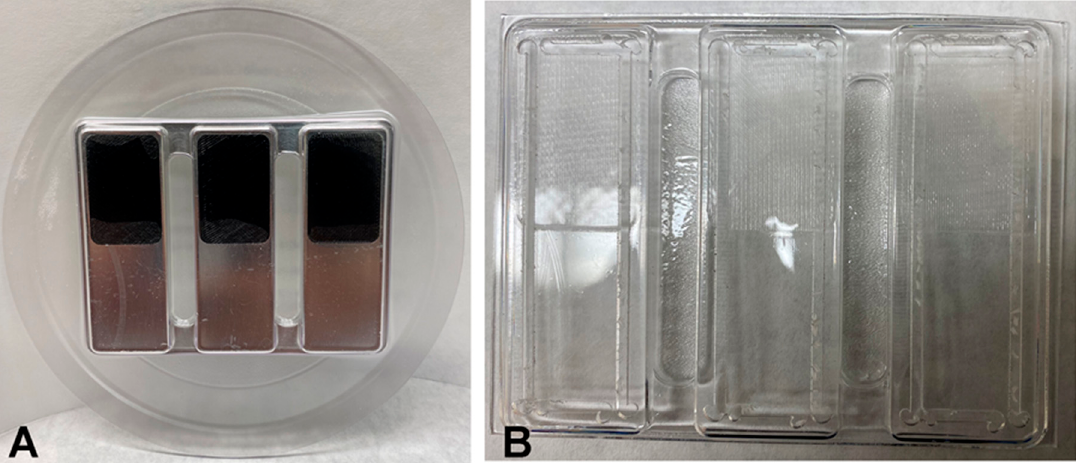
Figure 1. The metal molds with textured inserts ( A ). The copolyester retainer materials with different surface textures after thermoforming ( B ).